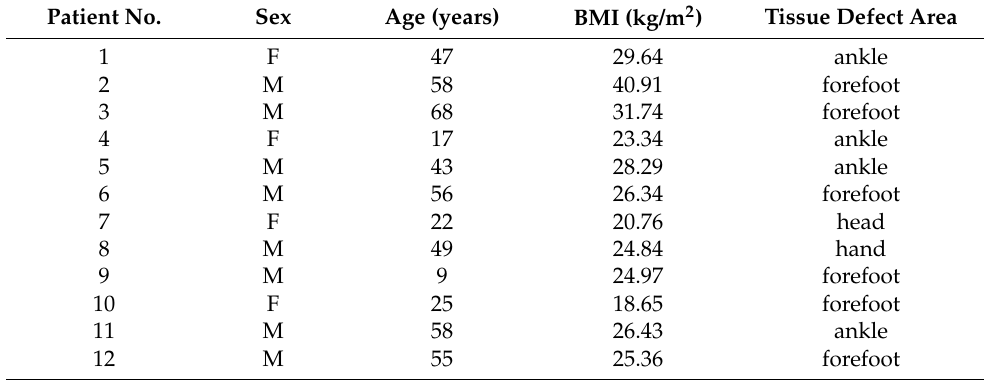
Table 2. Overview of general patient